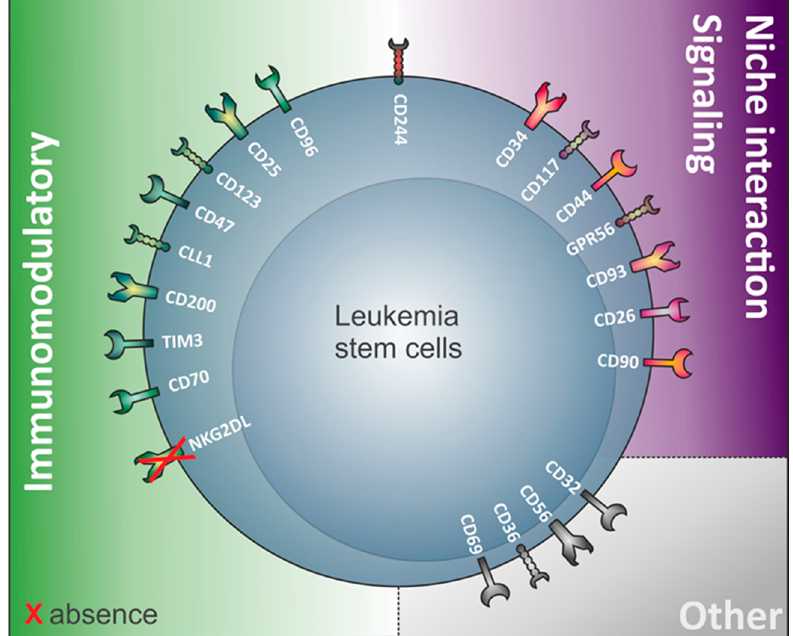
Figure 1. Surface antigens involved in leukemic stem cells (LSC) identification. Several surface proteins involved in LSC identification are involved in immune processes (e.g., TIM-3, CLL-1, CD47…) or interactions with the bone marrow niche (e.g., GPR56, CD44…).